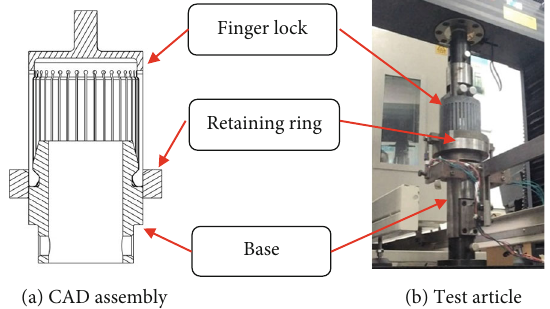
Figure 11: The pull rod strain gauge in the experiment. (a) Assembly drawing. (b) Test article.